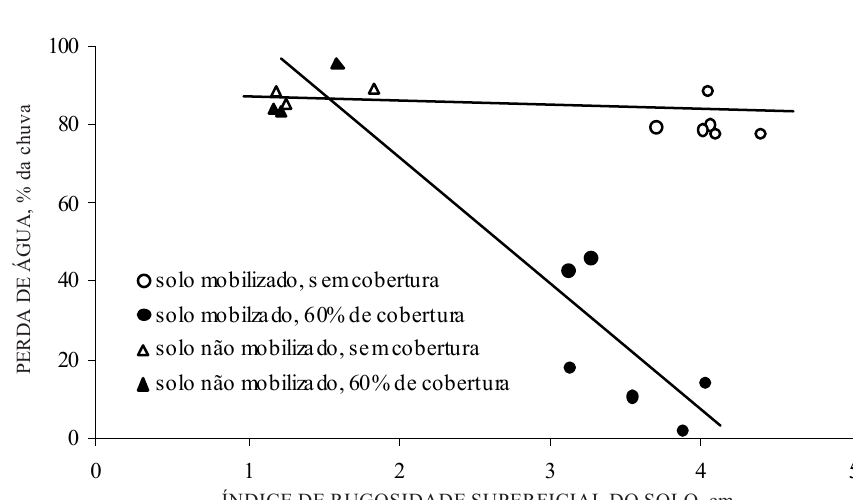
Figura 4. Relação da perda de água com o índice de rugosidade superficial do solo nos tratamentos